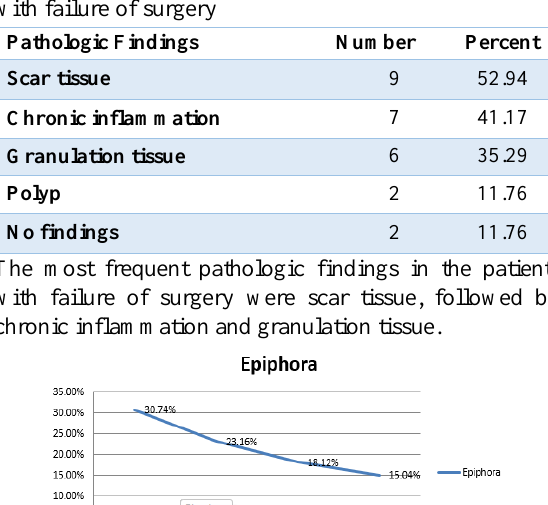
Table 3. Distribution of Pathologic Findings in patients